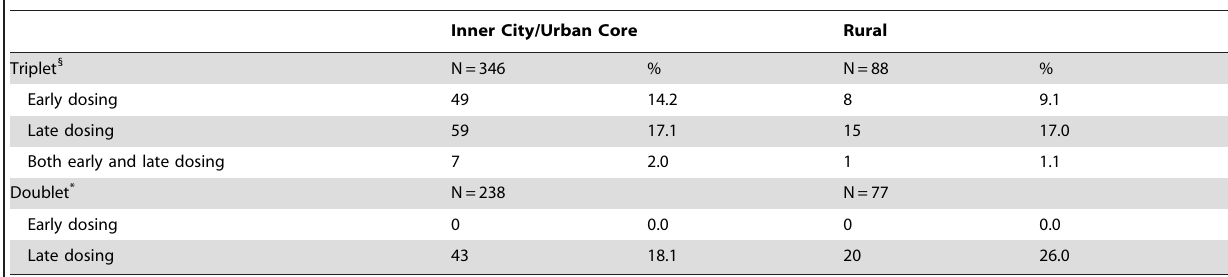
Table 3. Mistimed HPV4